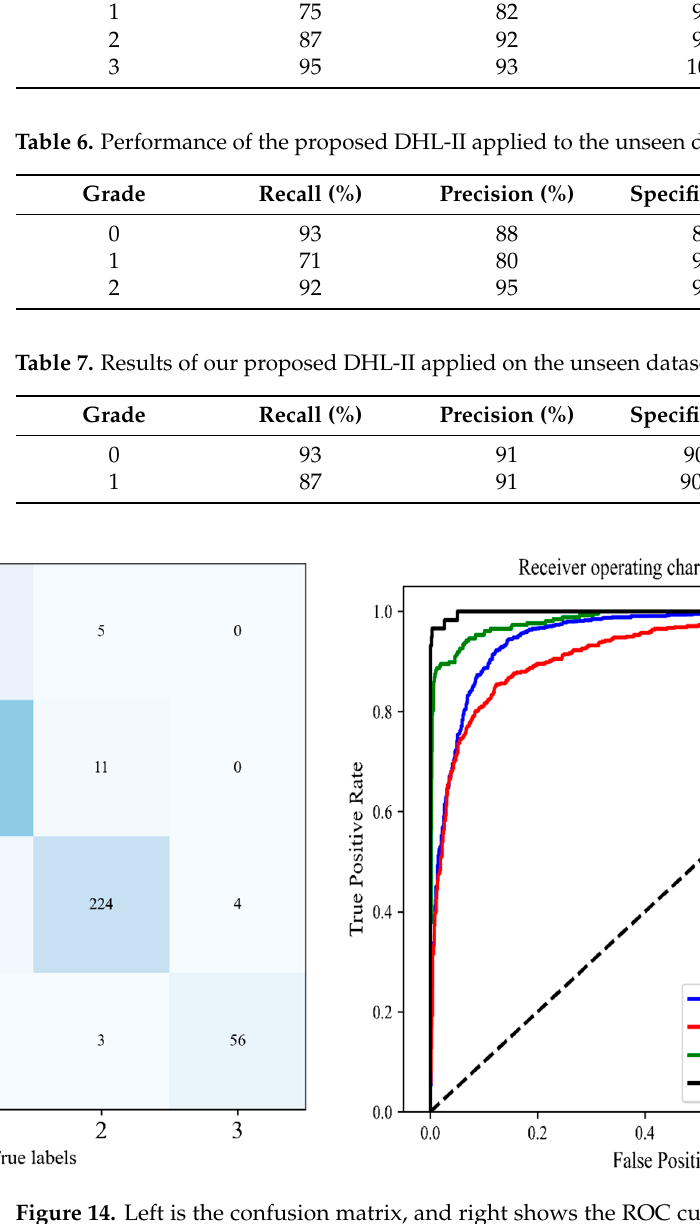
Figure 15. Left is the confusion matrix, and right shows the ROC curve obtained from DHL-II for classifying knee OA using three classes.